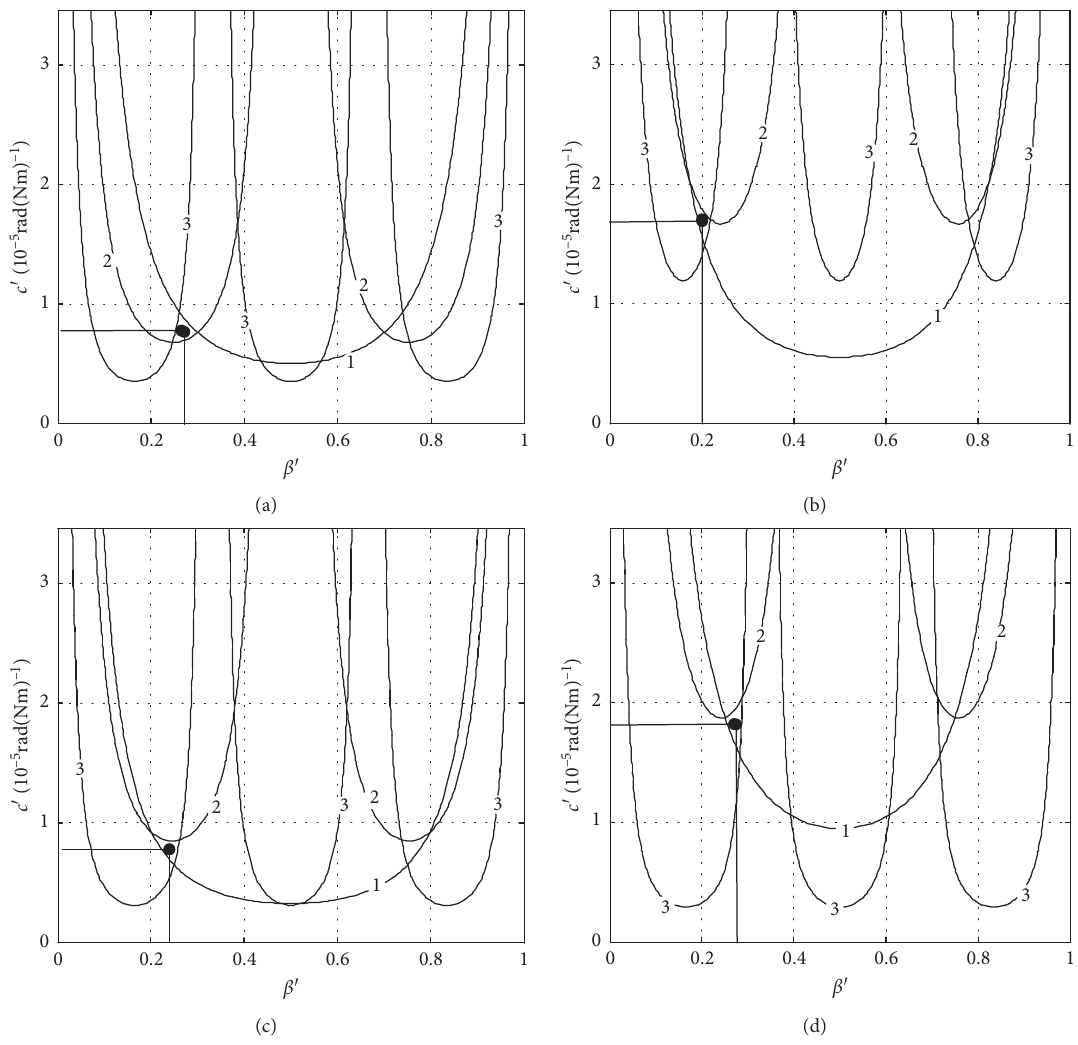
Figure 6: Measurement results of the local flexibility of crack. (a) Condition I (b) Condition II. (c) Condition III. (d) Condition IV. 1: the first order natural frequency influence curve. 2: the second order natural frequency influence curve. 3: the third order natural frequency influence